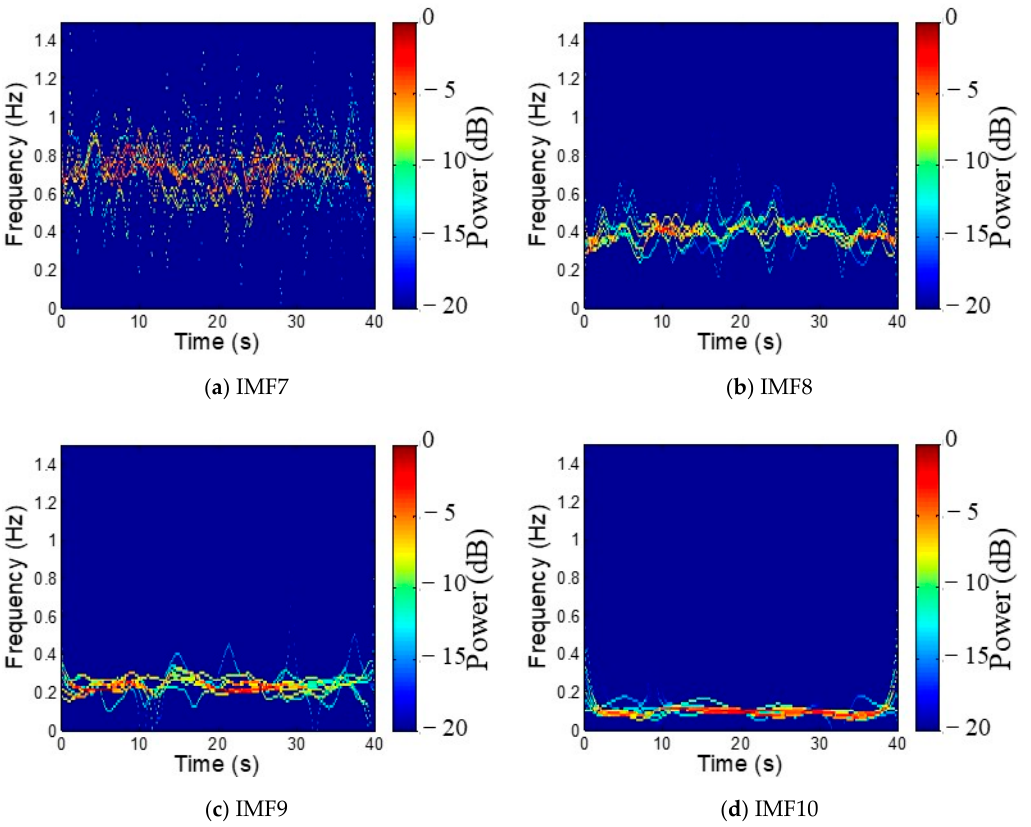
Figure 13. Hilbert spectrum of the 7th–10th IMFs of X-direction. ( a ) IMF7; ( b ) IMF8; ( c ) IMF9; ( d ) IMF10.